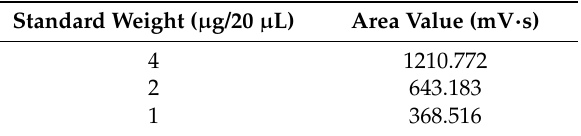
High performance liquid chromatography (HPLC) quantitative analysis results of α -spinasterol-3-O- β -D-glucopyranoside.